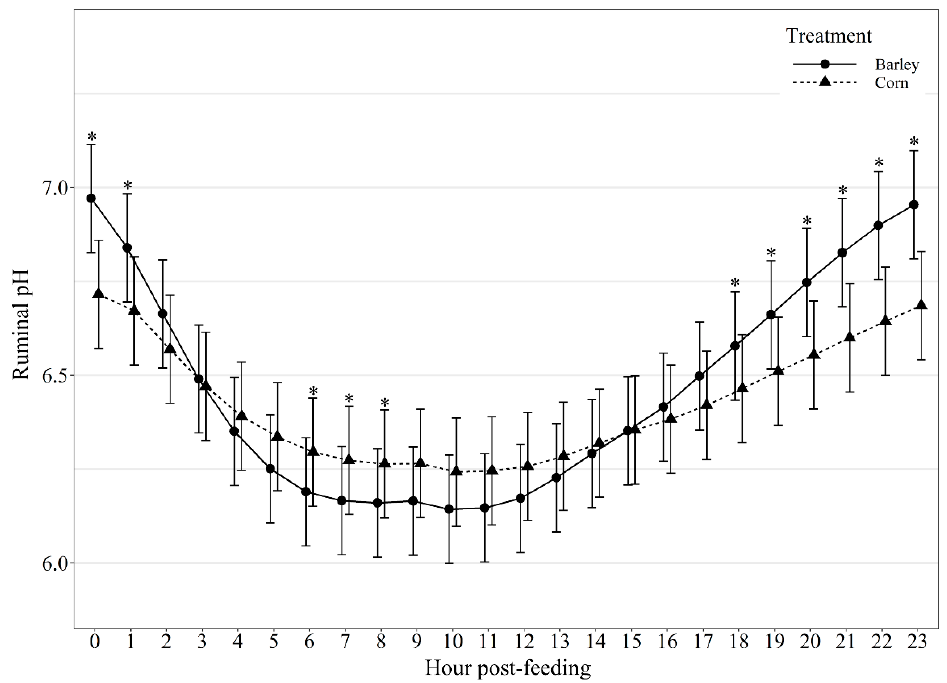
Figure 2. Diurnal pH patterns of beef steers fed once daily (0800) barley- or corn-based feedlot diets. Ruminal pH was influenced by diet × hour post-feeding interaction ( p < 0.01) and differences ( p ≤ 0.05) within hour post-feeding are denoted by *.